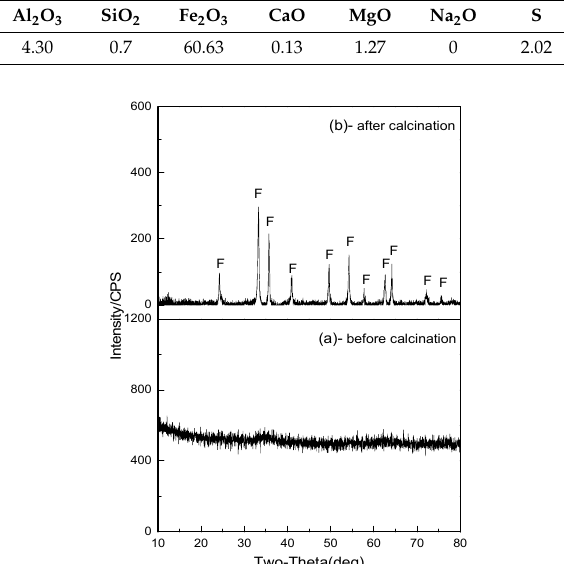
Table 6. Chemical composition of precipitate without calcination (wt %).